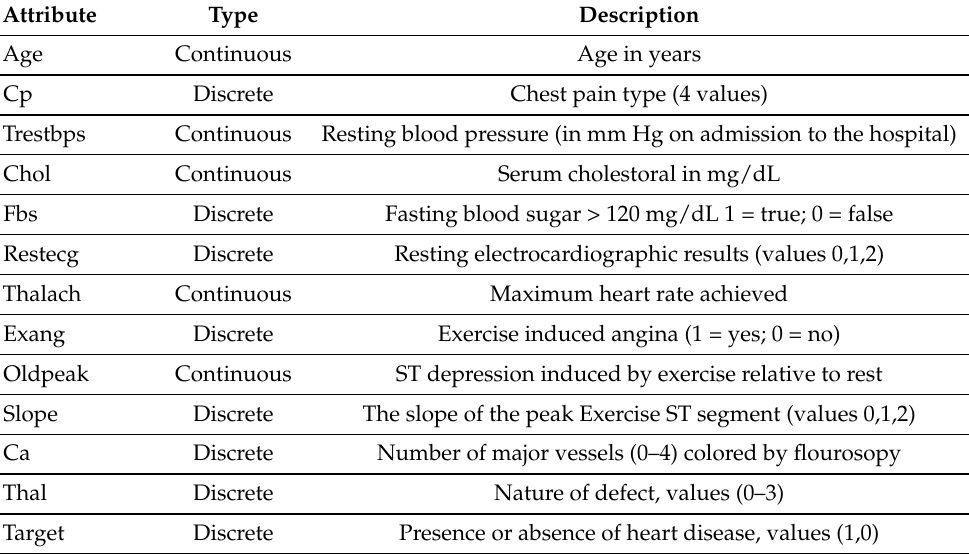
Table 1. Thirteen attributes of the Heart UCI (University of California, Irvine, CA, USA) dataset.